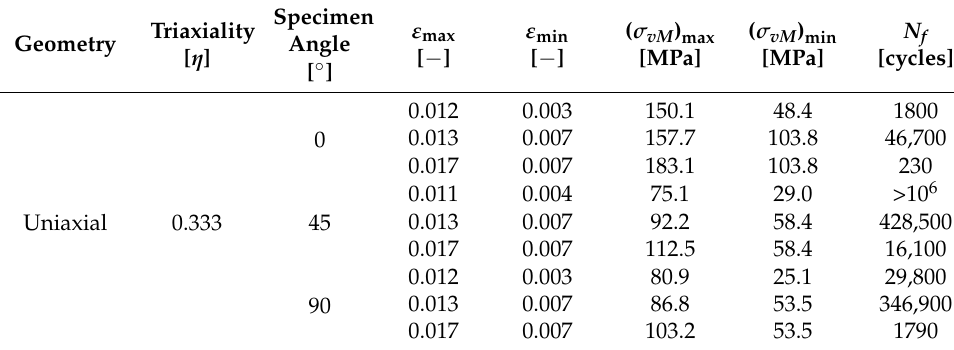
Table 4. Summary of fatigue experiments on the uniaxial, notched, complex, and cross-member specimens of